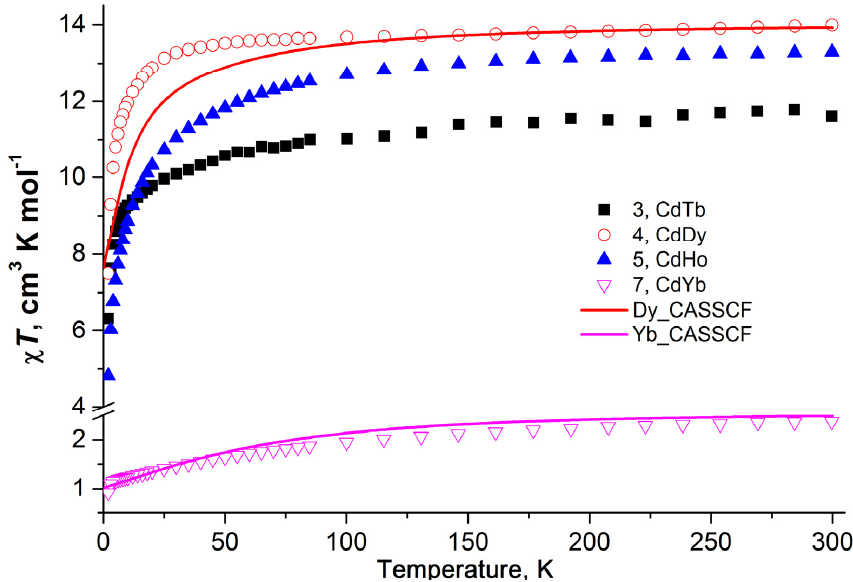
Figure 5. Temperature dependences of χ M T for 3 – 5 and 7 ( H = 5000 Oe). Solid lines are the results of modeling based on high-level quantum chemicals. The best correspondence between the experimental and calculated χ M T vs. T curves was achieved at Δ Tb = − 15.9 cm − 1 , zJ = − 0.04 cm − 1 for 3 ( g Tb = 3/2, R 2 = 6.1 × 10 − 4 , which is defined as R 2 = Σ ( χ T calc − χ T obs ) 2 / Σ ( χ T obs ) 2 ), Δ Dy = 3.9 cm − 1 for 4 ( g Dy = 4/3, R 2 = 6.7·10 − 4 ), Δ Ho = 10.0 cm − 1 , zJ = − 0.18 cm − 1 for 5 ( g Ho = 5/4, R 2 = 3.1·10 − 3 ) and Δ Yb = 125 cm − 1 , zJ = − 0.73 cm − 1 for 7 ( g Yb = 8/7, R 2 = 2.8·10 − 4 ) (Figure S8). The values of Δ Ln are quite close to the values, reported previously for Dy [37] and Ho [69], however, the correspondence between the experimental and calculated χ M T vs. T curve for 5 was not very good ( R 2 > 3·10 − 3 ). Thus, simple model based on the above Hamiltonian cannot describe magnetic properties of these two complexes adequately. We also used the SINGLE_ANISO code and the results of SA-CASSCF/SO-RASSI calculations for model clusters 4m and 7m to simulate the χ M T temperature dependences for 4 and 7 (see Section 3.6, Figures S9 and S11, Supplementary material). Indeed, our ab initio modeling, which takes into account the temperature-dependent population of Kra- mers doublets of isolated model clusters (Table 3), is in good agreement with experiment for 7 and in reasonable agreement—For 4 (Figure 5). Table 3. Calculated at the SA-CASSCF/SO-RASSI level energies, corresponding g-tensors, and crys- tal field wave functions for Kramers doublets (KDs) of the ground state multiplets: the 6 H 15/2 of Dy III in 4m and 2 F 7/2 of Yb III in 7m . Complex KDs KD Energies, cm − 1